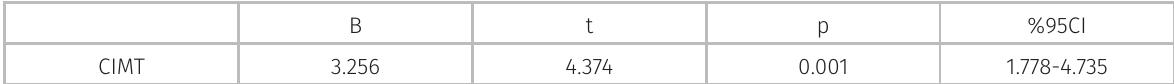
Table VI. Independent predictors for Aortic velocity propagation (AVP) by multivariate linear regression analysis. B t p %95CI CIMT -30.869 -4.105 <0.001 -45.806 (-) -15.931 Glucose -0.112 -3.411 0.001 -0.178 (-) -0.047 Age -0.484 -2.500 0.014 -0.868 (-) -0.099 CIMT, carotid intima-media thickness. B, Regression coefficient; t, Degree of freedom; CI, confidence interval; p<0.05 was considered statistically significant. (R 2 =0.714 F=31.632). (p>0.05 was excluded).